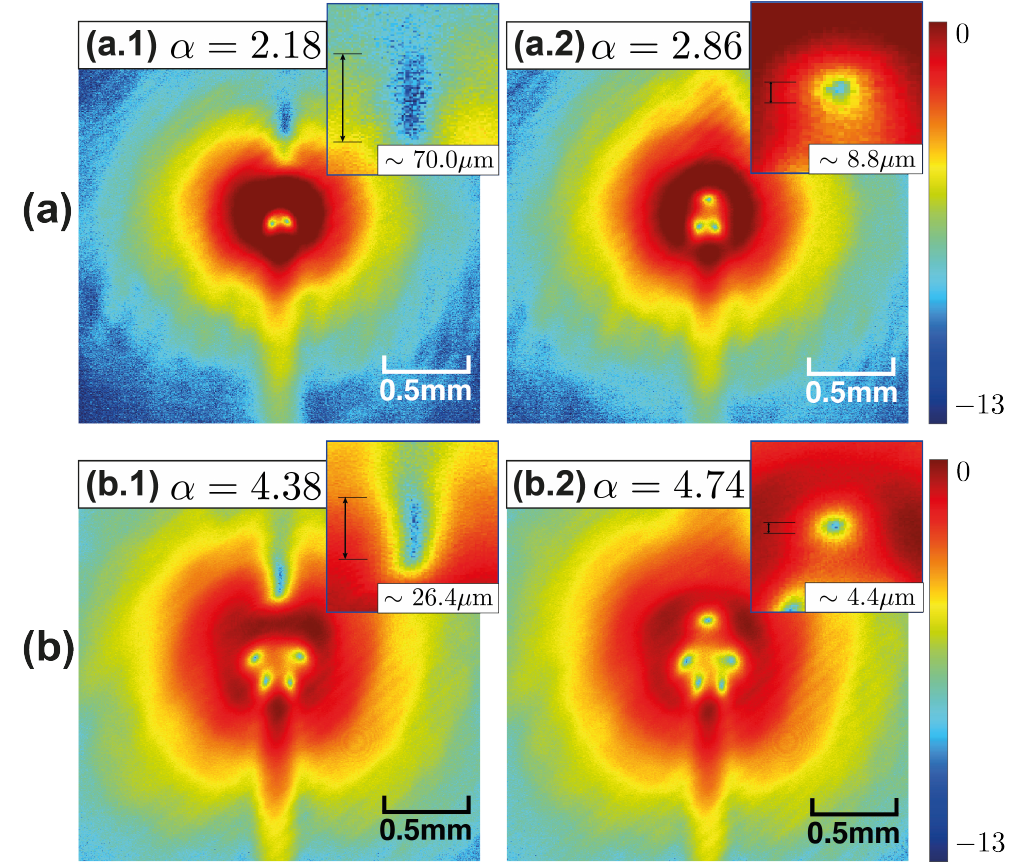
Figure 6. Experimental results: far-field intensity profiles (logarithmic scale). ( a ) Phase transition α ,2 → 3. ( a.1 ) α = 2.18. ( a.2 ) α = 2.86. ( b ) Phase transition α ,4 → 5. ( b.1 ) α = 4.38. ( b.2 ) α = 4.74. Top right: zoomed local minimum for resident vortex position. Table 1. Estimated topological charge | α | via interpolation from resident vortex experimental distance curves, d exp (µm). Data correspond to Figure 6 samples: α = 2.18, α = 2.86, α = 4.38, and α =